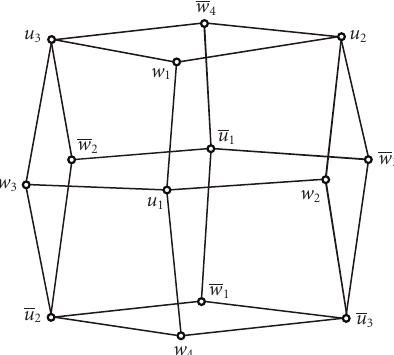
Figure 1: The Rhombic